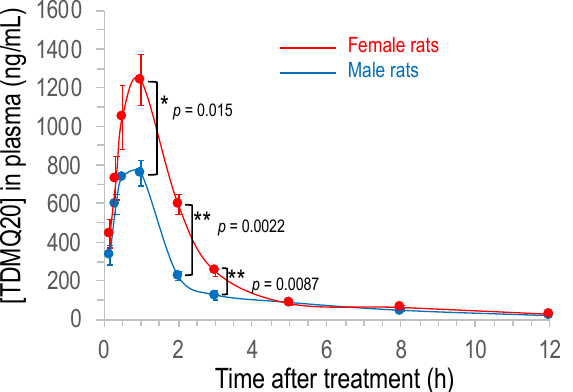
Figure 3. Plot of the concentration of TDMQ20 detected by LC–MS/MS in rat plasma as a function of time after oral administration of the drug (25 mg/kg). Mean values of 6 female and 6 male rats (red and blue traces, respectively), bars stand for SEM. The p -values were determined using unpaired t -test (Mann–Whitney); ** stands for p -value < 0.01, * stands for 0.01 < p -value < 0.05.